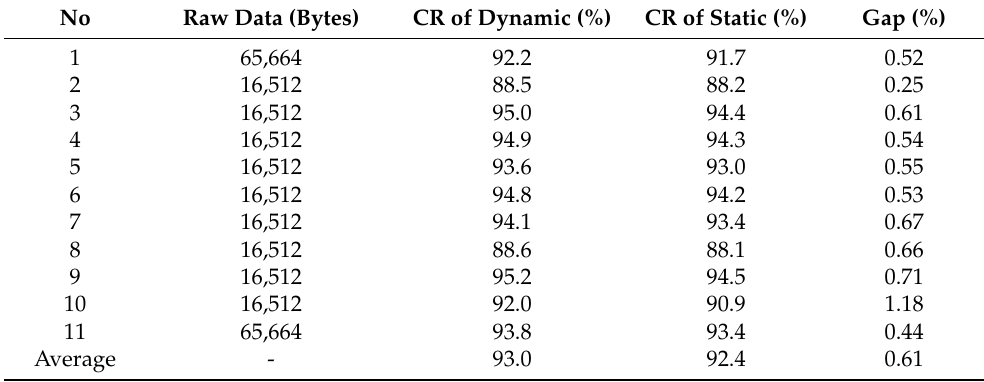
Table 1. Compression ratio between the dynamic-Huffman and the static-Huffman. CR, compres- sion ratio.